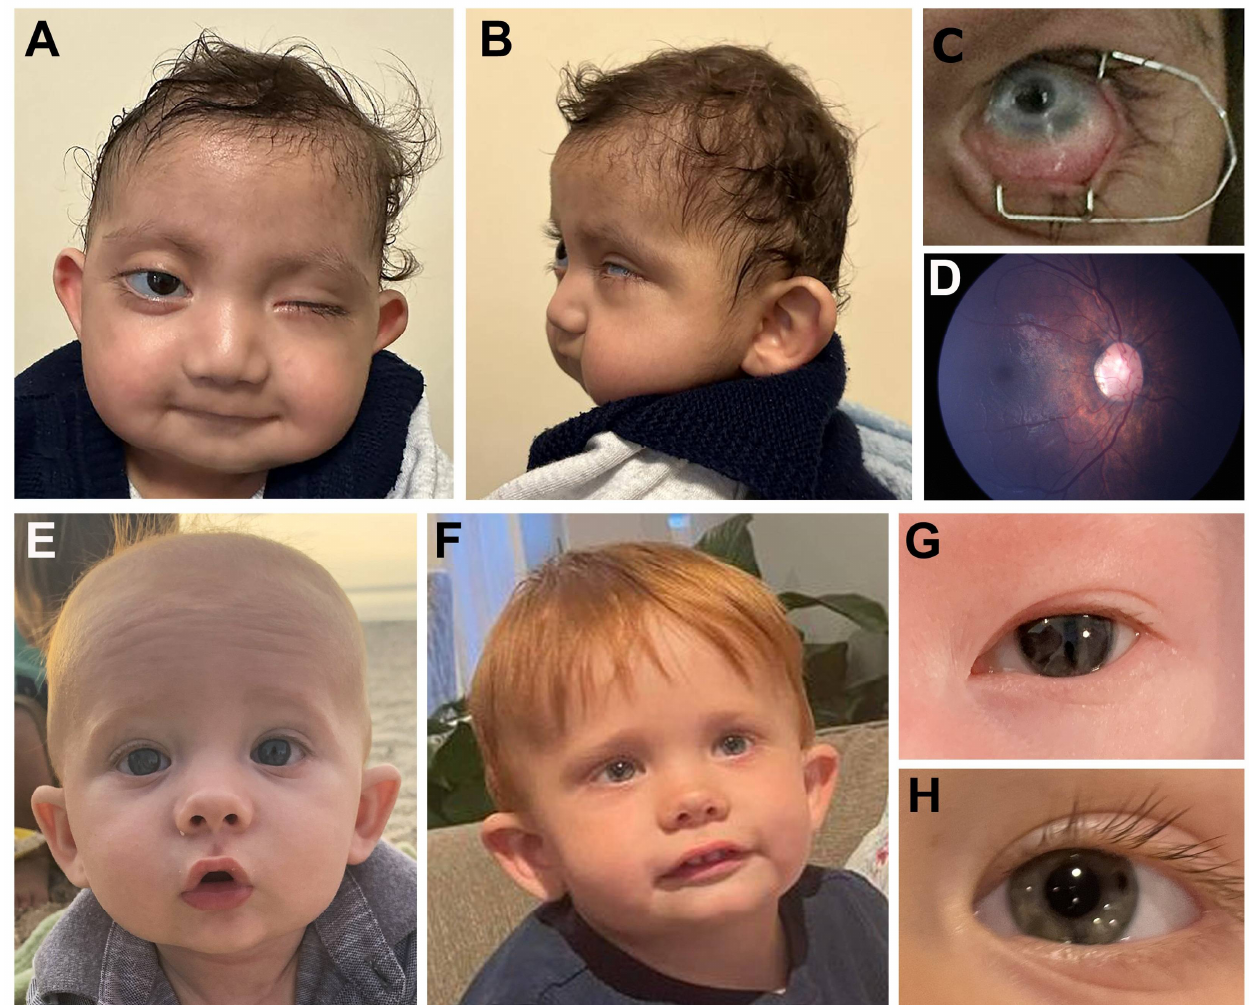
Figure 1. Clinical images. ( A – D ). Individual 2 with KMT2D pathogenic variant showing micro- cephaly, smooth philtrum, thin upper lip and low-set cupped ears ( A , B ), left eye microphthalmia and sclerocornea (peripheral) ( C ), and right fundus photograph showing anomalous optic nerve ( D ). ( E – H ). Individual 7 with SETD1A pathogenic variant showing high forehead, depressed nasal bridge and cupped ears at 4 months ( E ) and 2 years ( F ) of age along with ocular photos showing slit pupil at 4 days of age ( G ) which had resolved by 2 years of age ( H ). Individual 1 is a 5-year-old white (Canadian) male with a clinical diagnosis of a Peters plus-like syndrome. He has unilateral ocular anomalies consisting of type-2 Peters anomaly, nystagmus and a central retinal scar. Craniofacial features include discolored central in- cisors, microcephaly, deep set eyes, up-slanting palpebral fissures, smooth philtrum, thin upper lip, cupped ear and white locks of hair in the posterior hairline. He also has a congen- ital heart defect (perimembranous VSD, pulmonary stenosis), chronic lung disease, Grade 3 vesicoureteral reflux, a feeding disorder requiring g-tube, C2-C3 subluxation and right hip dislocation. Growth and development are affected with severe cognitive impairment and borderline short stature (third centile). Exome sequencing identified a likely pathogenic variant in KMT2D , c.1300del p.(Leu434*), which was not present in the mother (father unavailable); this variant has been reported as pathogenic in ClinVar